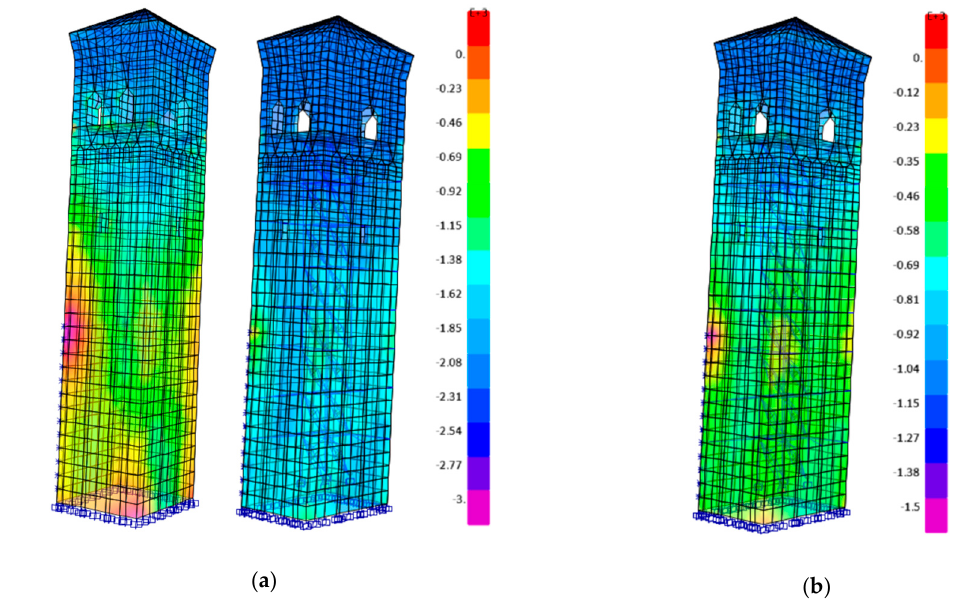
Figure 25. Contour plot of S 22 (vertical compression) stress values: ( a ) tower before and after retrofitting shown together by using the same contour interval ([ − 3000, 0] kN/m 2 ); ( b ) tower after retrofitting shown alone with a specific contour interval setting ([ − 1500, 0] kN/m 2 ). Results were derived from nonlinear dynamic analysis TH n. 2.